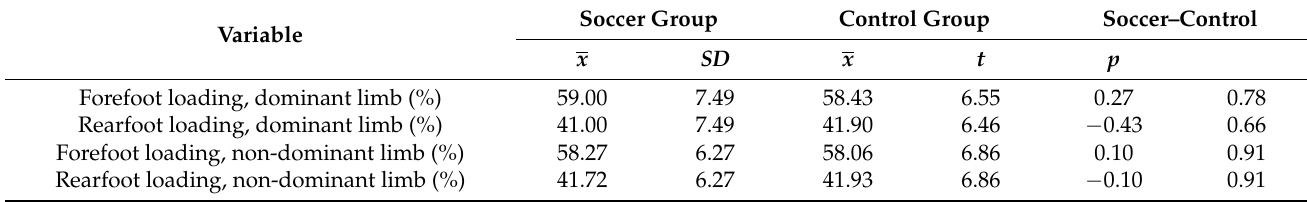
Table 5. Mean ( x ), standard deviation (SD) and t-test results for plantar pressure distribution in the dominant and non-dominant limbs (forefoot/rearfoot loading) in the dynamic test.